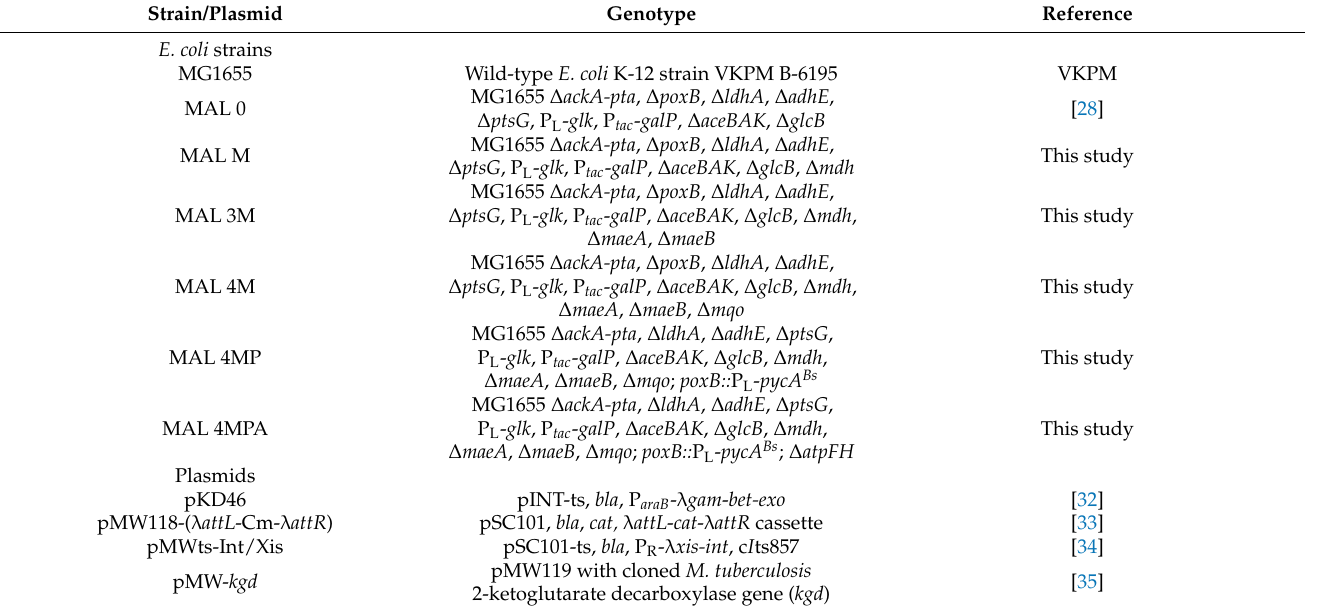
Table 1. Bacterial strains and plasmids used in this